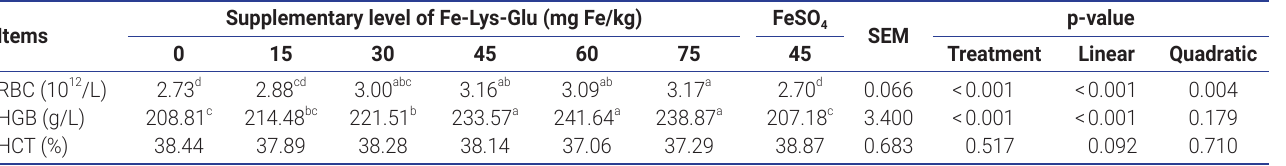
Table 5. Effects of dietary Fe-Lys-Glu supplementation on blood biochemical parameters of laying hens Supplementary level of Fe-Lys-Glu (mg Items